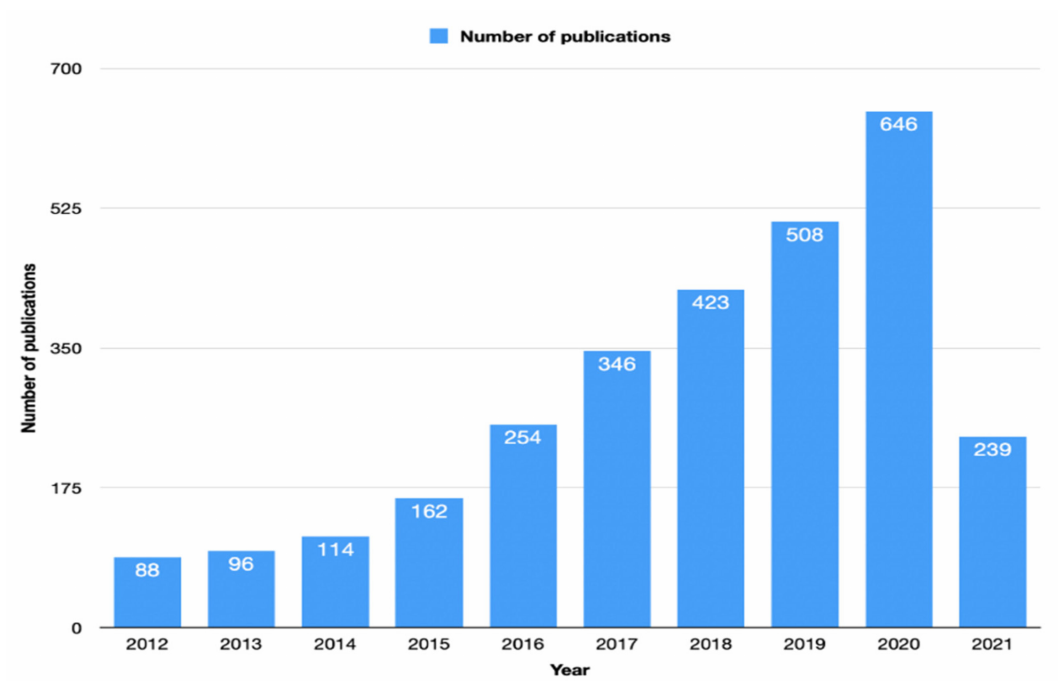
Figure 2. The number of articles during the last 10 years related to immunotherapy in colorectal cancer according to the Web of Science database.